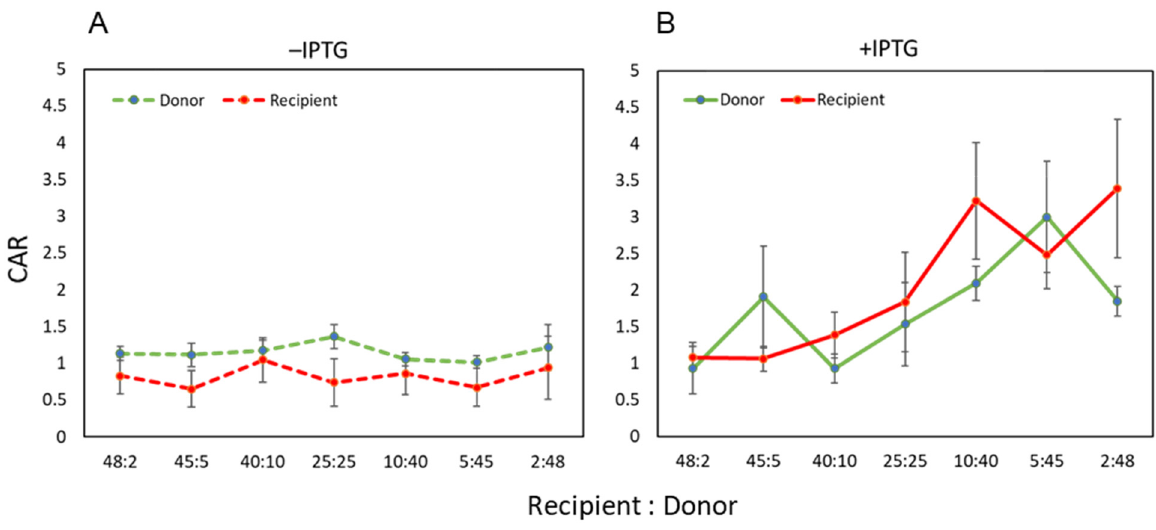
Figure 2. The CAR values without ( A ) and with ( B ) IPTG. The values are the means ± SD of three independent experi- ments.